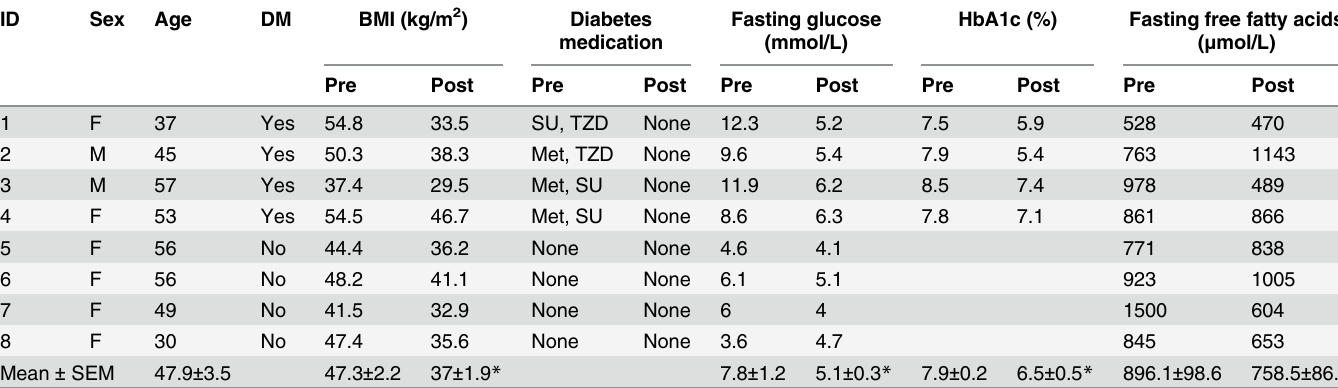
Table 2. Clinical characteristics and biochemical observations for obese volunteers before and after weight loss surgery. ID Sex